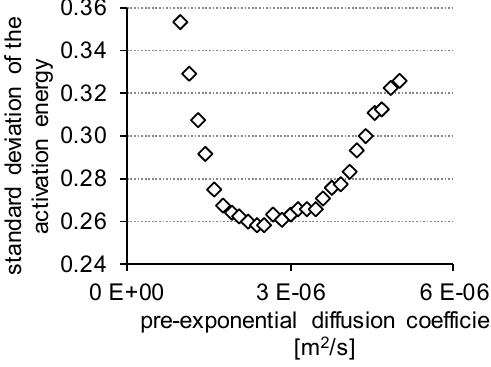
Figure 21. Representation of the standard deviation.